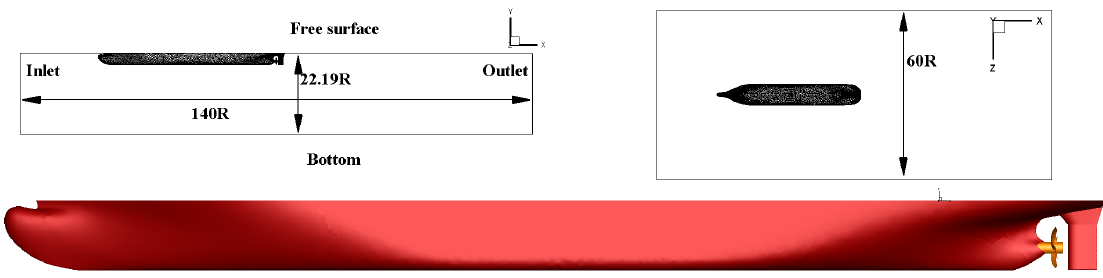
Figure 32. Boundaries in the finite volume mesh used in RANS simulations for the design draft